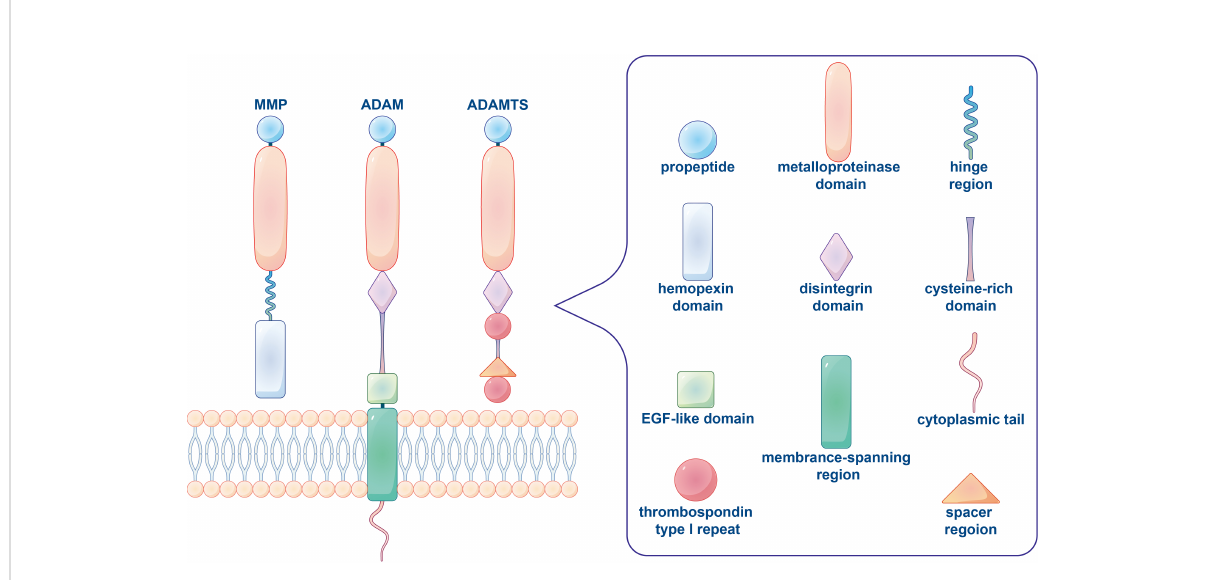
FIGURE 1 The typical domain structure of human metalloproteinases (MMP, ADAM, ADAMTS). An archetypal MMP orderly contains a propeptide, a catalytic metalloproteinase domain, a linker peptide (hinge region) and a hemopexin domain. ADAM is a class of transmembrane protein with characterized structure including a propeptide, a metalloproteinase domain, a disintegrin domain, a cysteine-rich domain, an EGF-like domain, a membrane-spanning region and a cytoplasmic tail. The basic domain organization of ADAMTS comprises a propeptide, a metalloproteinase and disintegrin-like domain, a thrombospondin type 1 repeat (TSR), a cysteine-rich domain and a spacer region, while lacked a transmembrane region, cytoplasmic domain and EGF-like